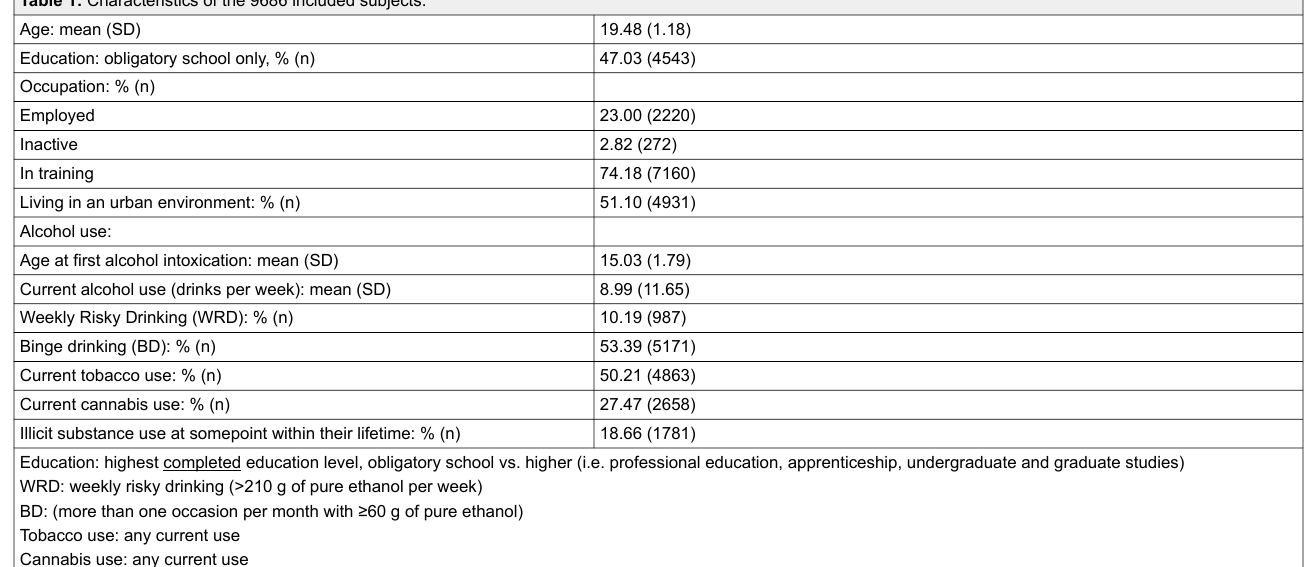
Table 1: Characteristics of the 9686 included subjects.